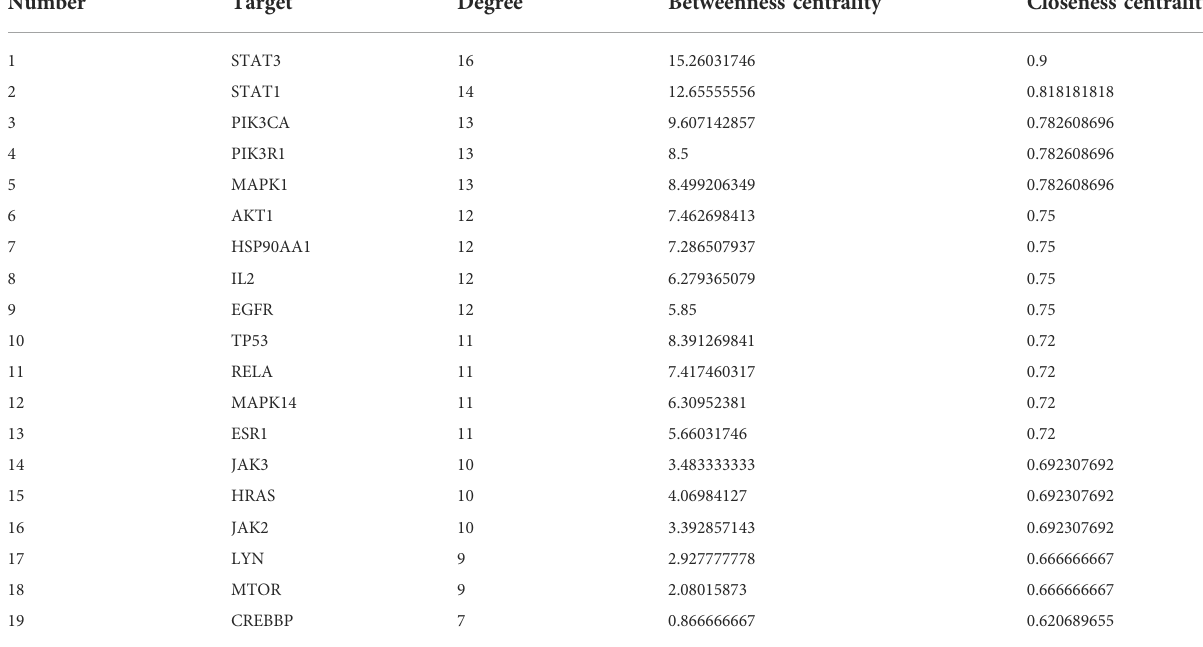
TABLE 3 Basic information of the key targets of LJAW in the treatment of gastrointestinal reactions caused by chemotherapy for CRC. Number Target Degree Betweenness